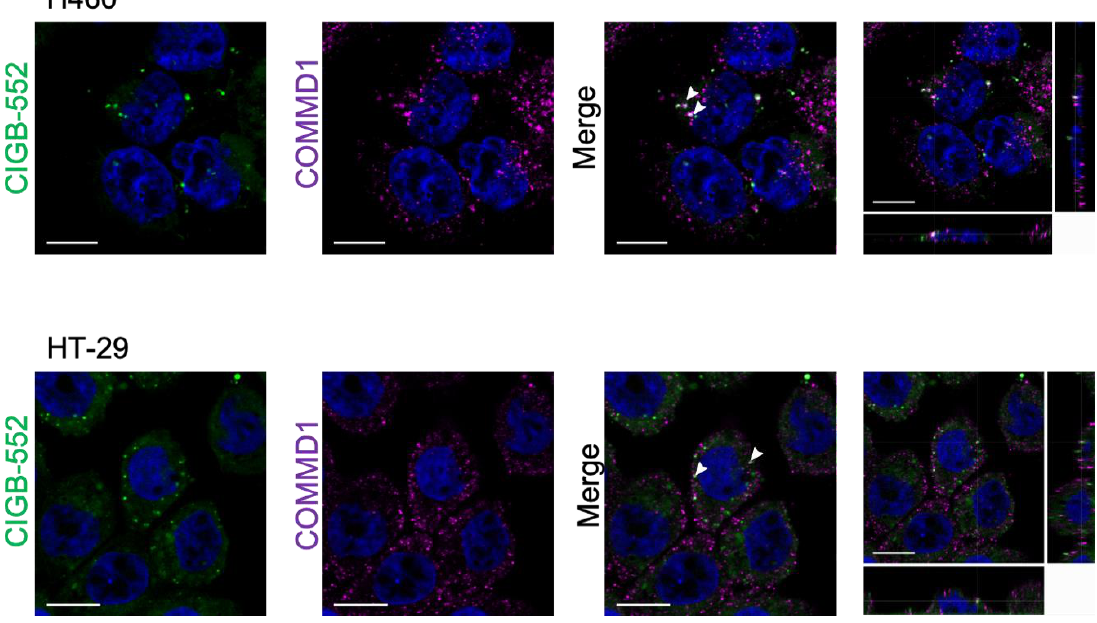
Figure 3. Interaction between CIGB-552 and COMMD1 in H460 and HT-29. Cells were incubated with 100 µ M of CIGB-552 conjugated to FITC (green) and COMMD1 in situ interaction was detected 24 h later by confocal microscopy. Nuclei were labelled using TOPRO-3 probe (blue) and COMMD1 was detected with a secondary antibody labelled with Cy5 (magenta) (scale bar = 10 µm).